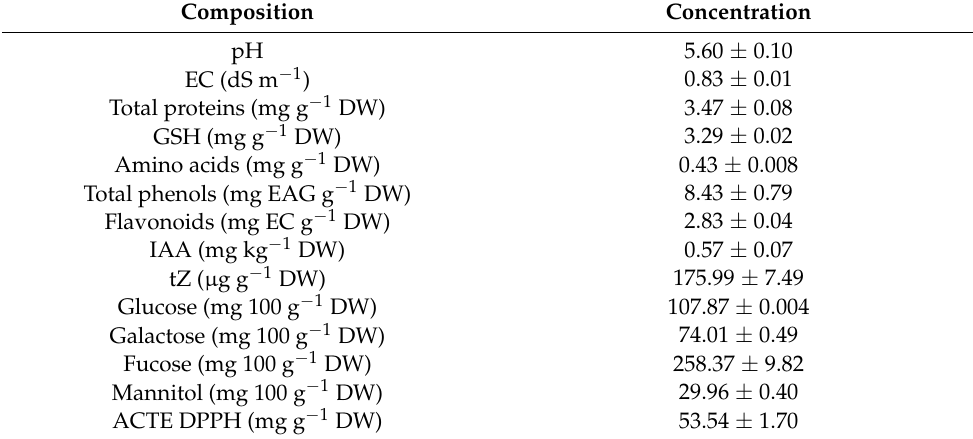
Table 3. Biochemical characterization of